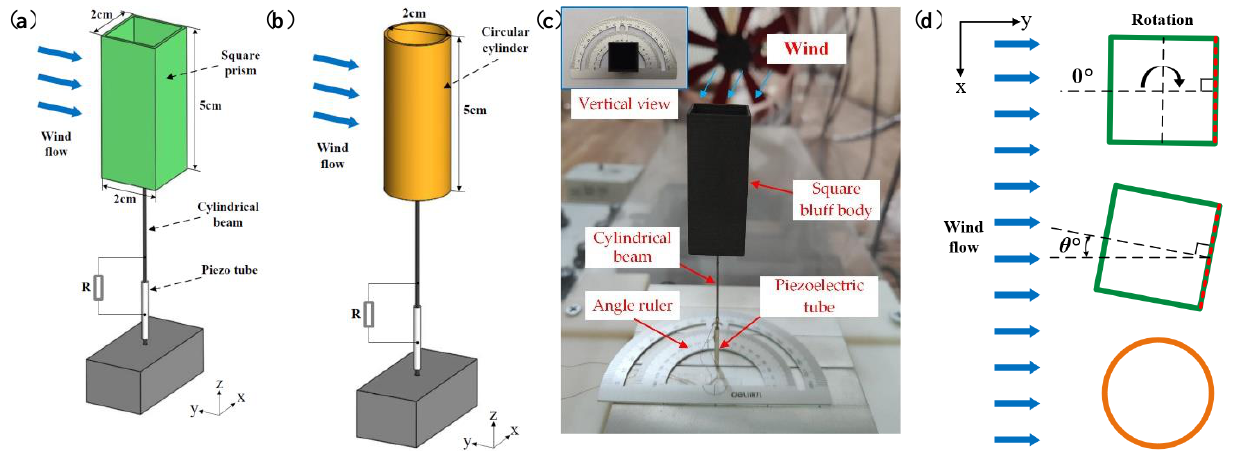
Figure 1. ( a ) Schematics of the two-dimensional omnidirectional harvester with a square prism and ( b ) circular cylinder. ( c ) The harvester with a square prism in the wind tunnel and ( d ) the rotation diagram of the system.